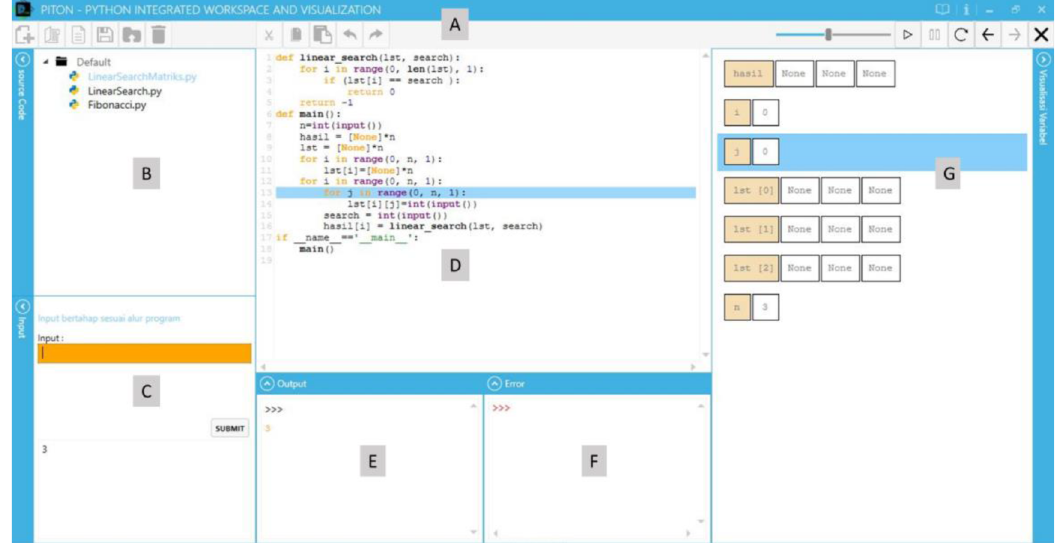
Figure 2. The user interface of PITON when all panels are